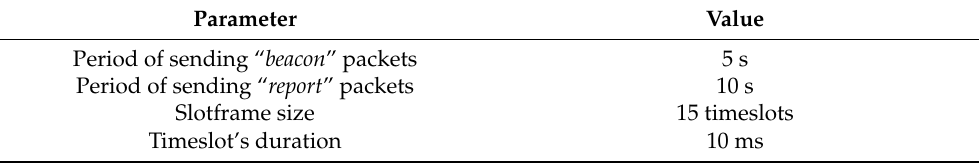
Table 1. Parameters used for TSCH with the Traffic Aware Scheduling Algorithm (TASA)